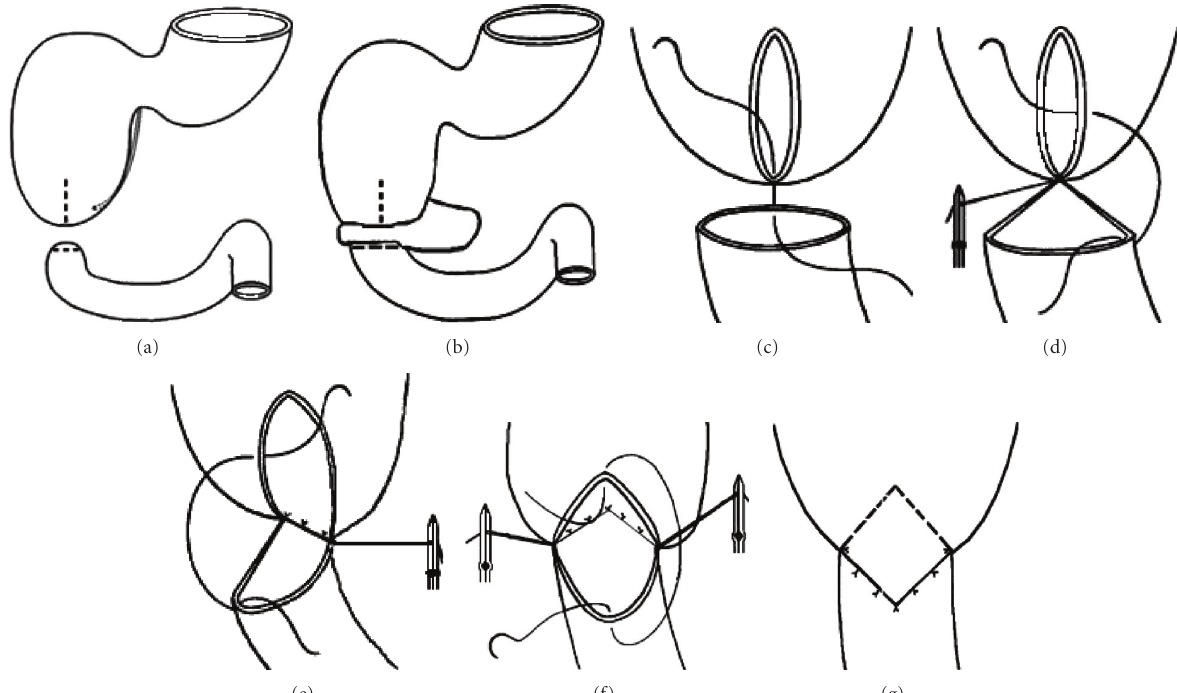
Figure 1: Personal modification (inverted diamond-shaped anastomosis): (a-b) longitudinal incision on the proximal dilated duodenum and transverse incision on the distal duodenum; (c-d-e-) anastomosis of posterior duodenal wall in a single layer with interrupted sutures; (f-g) anastomosis of the anterior duodenal